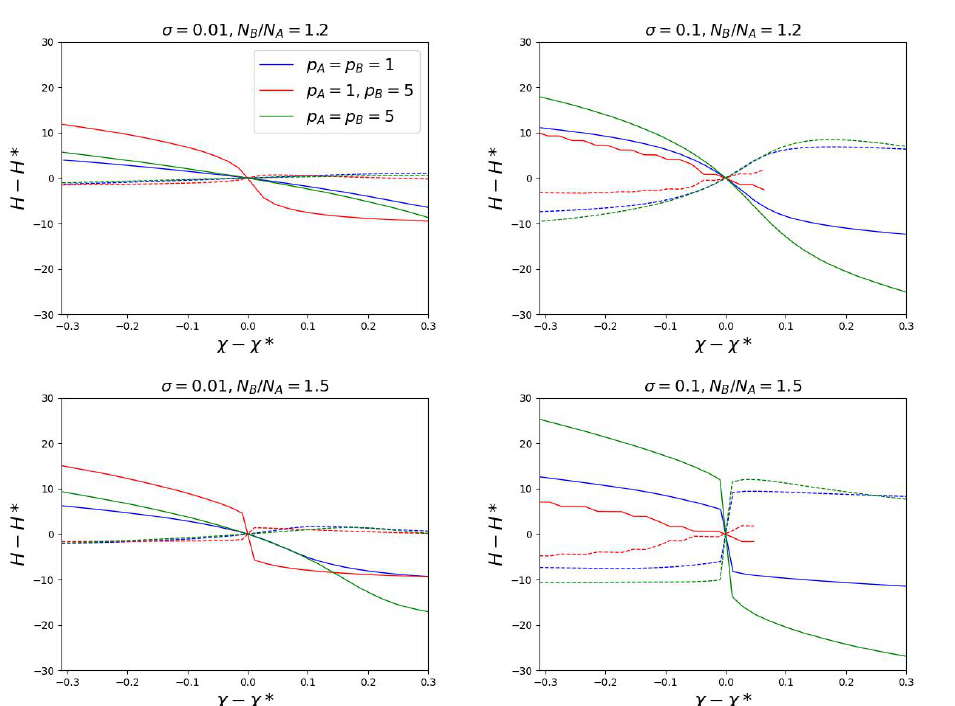
Figure 7. The first moments of the free ends distributions for chains A and B as a function of the solvent selectivity. Dashed lines indicate non-responsible chain A, solid lines indicate responsible chain